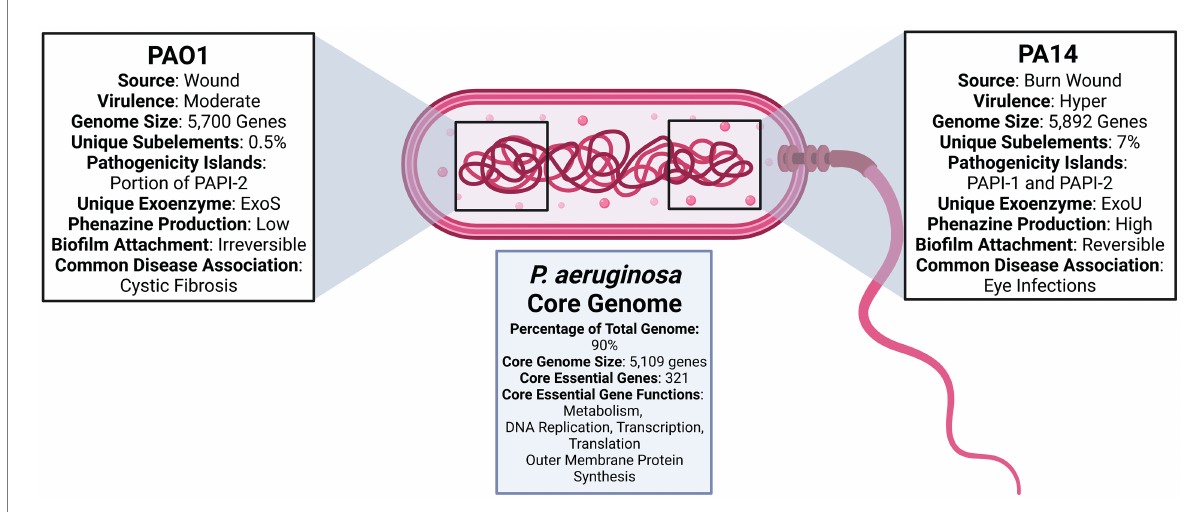
FIGURE 1 Diagram comparing Pseudomonas aeruginosa PAO1 and PA14 (Stover et al., 2000; He et al., 2004; Filloux, 2011; Mikkelsen et al., 2011; Ozer et al., 2014, 2019; Bosire et al., 2016; Mathee, 2018; Ozer, 2018; Chandler et al., 2019; Poulsen et al., 2019; Lee et al.,